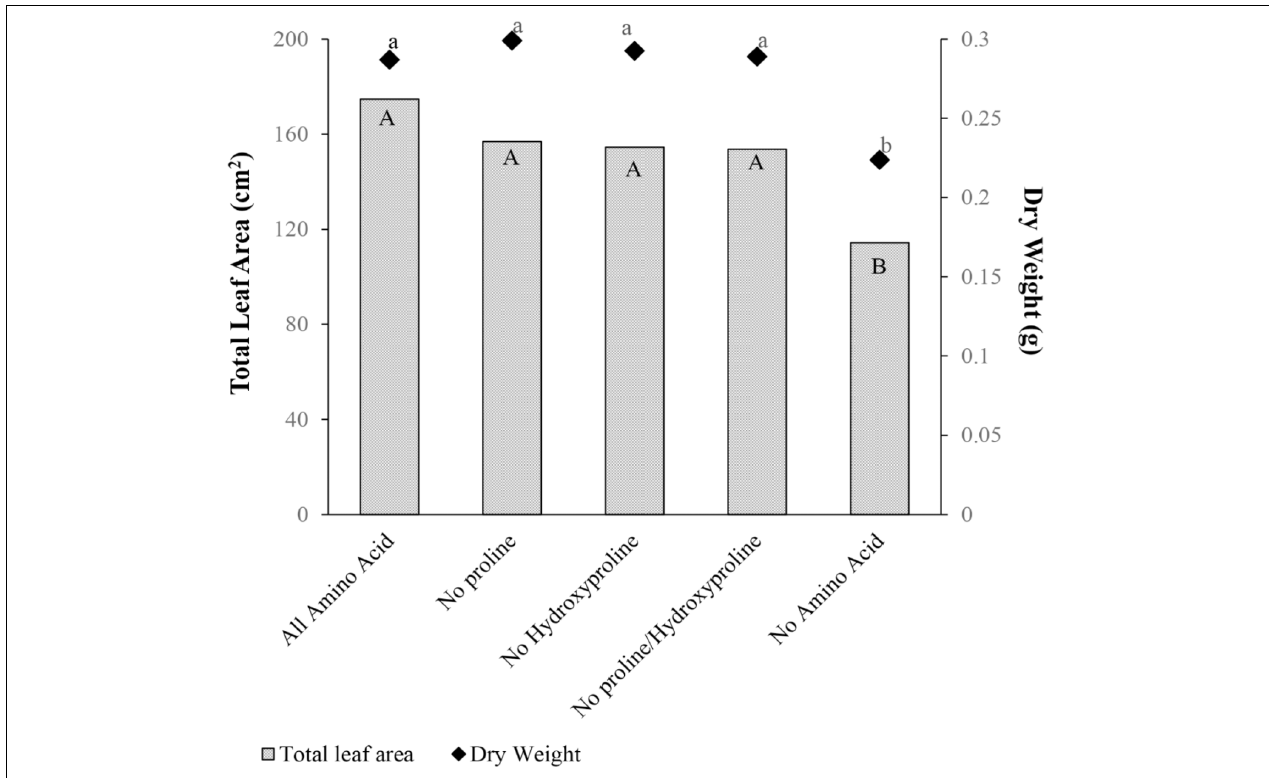
FIGURE 8 | Mean total leaf area (cm 2 ) and dry weight (g) 28 days after emergence of cucumber with five treatments: amino acid mixture containing all amino acids found in hydrolyzed collagen (All Amino Acid), all amino acids found in hydrolyzed collagen but proline replaced with glycine (No Proline), all amino acids found in hydrolyzed collagen but hydroxyproline replaced with glycine (No Hydroxyproline), and all amino acids found in hydrolyzed collagen but proline and hydroxyproline replaced with glycine (No Proline/Hydroxyproline), and Control (No Amino Acid). Data analyzed by ANOVA ( α = 0.05) and Tukey’s HSD test was conducted for mean separation. Letters (Capital letters for total leaf area and small letters for dry weight) not associated with same letter are significantly